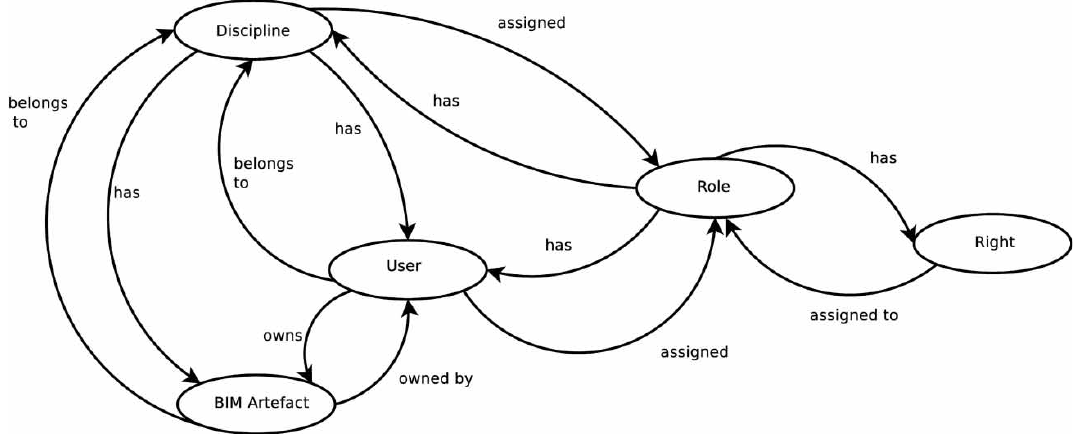
Fig. 6. Users, disciplines and